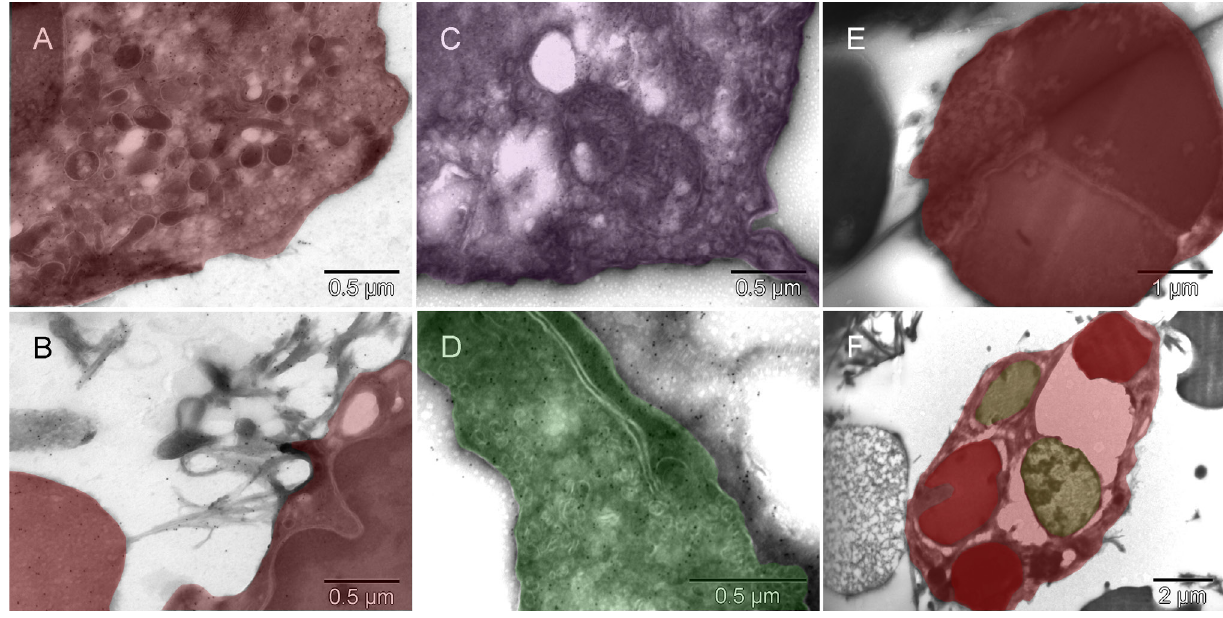
Figure S5. Cells of graft origin labeled with GFP under ubiquitin promoter. GFP-specific label was present in erythroblasts (red) [ A ], primitive erythrosomes (red) like the one separating from the cell that made it (left lower corner in [ B ]), platelets (purple) [ C ] and in EC (green) [ D ]. Morphologically interesting cells, erythroblast [ E ] and perishing hemangioblast [ F ] stained with nonspecific antibody are shown at low magnification (they had no gold grains). The erythroblast was entirely consumed by a successful incremental conversion into at least three erythrogenic vesicles (red) [ E ] and the cell with ambivalent phenotype [ F ], possibly hemangioblast, contained three internal vesicles resembling erythrosomes (red) and two of comparable size that appeared to be failing as erythrosomes (green) (partially electron lucent